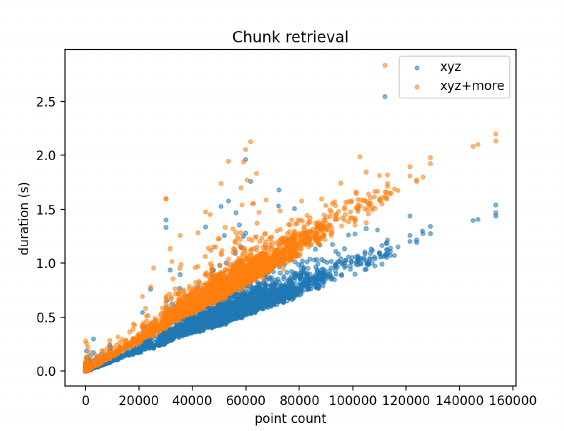
Figure 6. The histogram shows how many points are stored per Figure 7. The scatter plot shows how much time is spent (in octree node seconds) to answer a request, given the amount of points that are in the block. A clear trend can be observed between the amount Table 6. Averages for responses made by PCServe of point data and the time needed to produce the response. are straight forward to parallellize with multiple threads or pro- cesses (e.g. obtaining the nD histogram, querying for the octree layout can be performed per subtree of the childs of the root node, or multiple input files could be simultaneously loaded